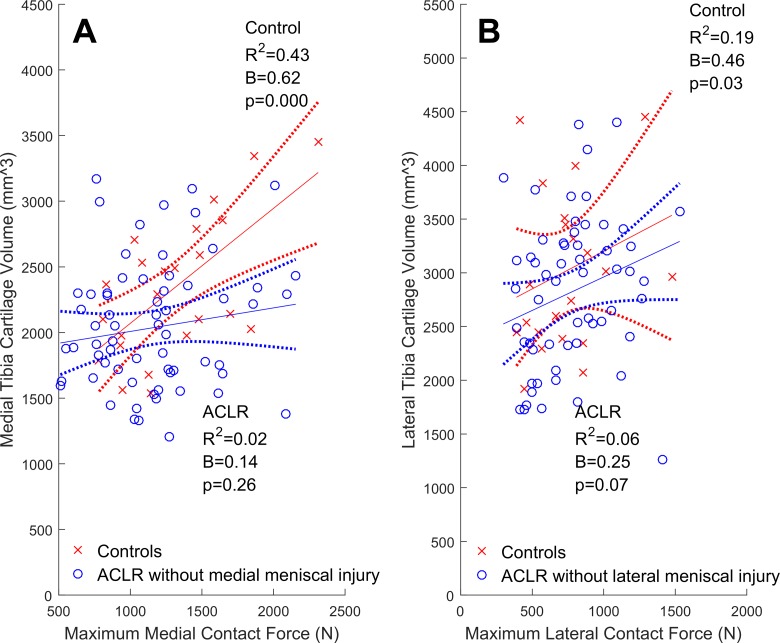
Tibial articular cartilage volumes (mm3) regressed onto maximum contact forces (N) with 95% confidence intervals (dotted lines) for isolated ACLR and healthy control knees in the (A) medial and (B) lateral compartments. ACLR, anterior cruciate ligament reconstruction.